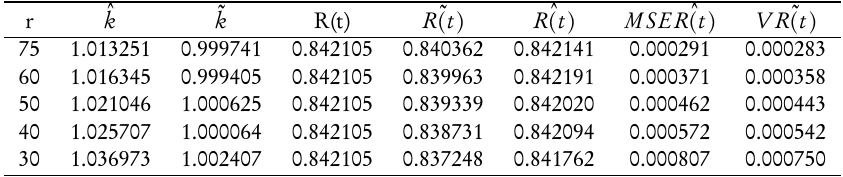
Estimates of k and R(t) for different number of observed failures, their corresponding variances and MSE.